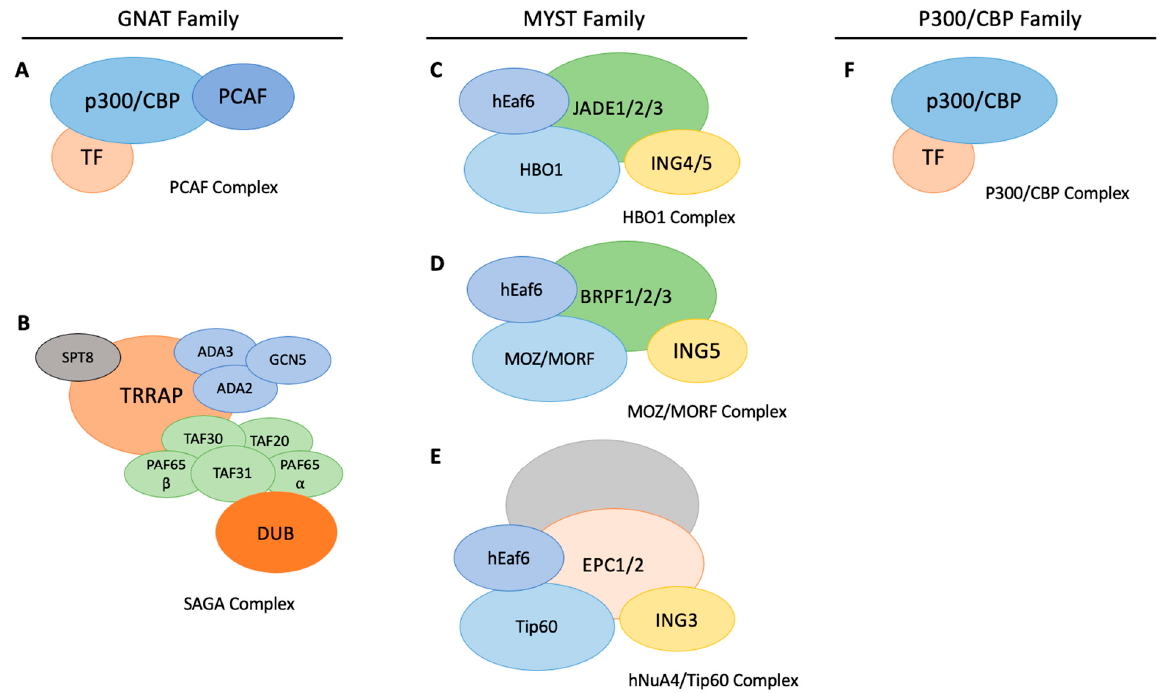
Figure 1. Examples of known KAT complexes from various KAT families. ( A ) The PCAF complex is composed of a DNA-binding transcription factor, p300/CBP, and bound to it is the GNAT-family KAT, PCAF. ( B ) The SAGA complex belongs to the GNAT family and uses GCN5 as the histone acetyltransferase. ( C ) The HBO1 complex is composed of the HBO1 histone acetyltransferase, ING4/5 as the histone-binding subunit, and JADE1/2/3 for scaffolding. ( D ) The MOZ/MORF complex is composed of MOZ/MORF acetyltransferase, BRPF1/2/3 for scaffolding, and ING5 for binding histones. ( E ) The hNuA4/Tip60 complex is composed of the Tip60 acetyltransferase, ING3 histone-binding subunit, and scaffolding subunit EPC1/2. The unlabeled structure behind EPC1/2 refers to variable components that are known to change depending on biological/cellular context. ( F ) p300/CBP complex is composed of a transcription factor that acts as a DNA-binding element and brings p300/CBP acetyltransferase to the chromatin.